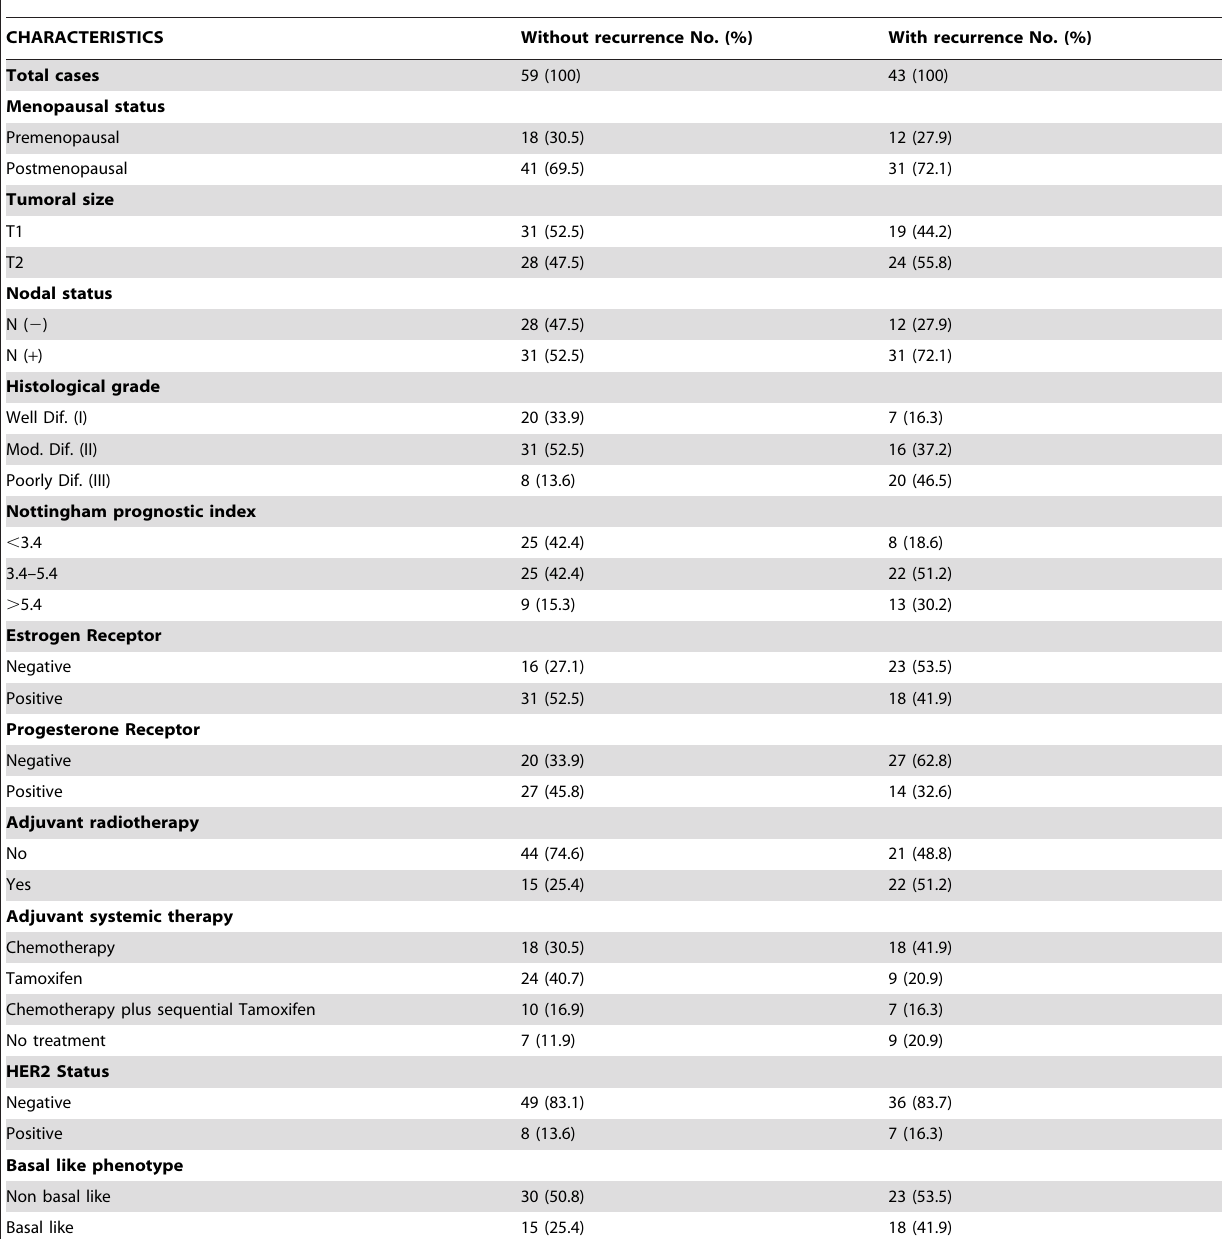
Table 1. Basal characteristics of 102 patients with invasive ductal carcinoma of the breast.